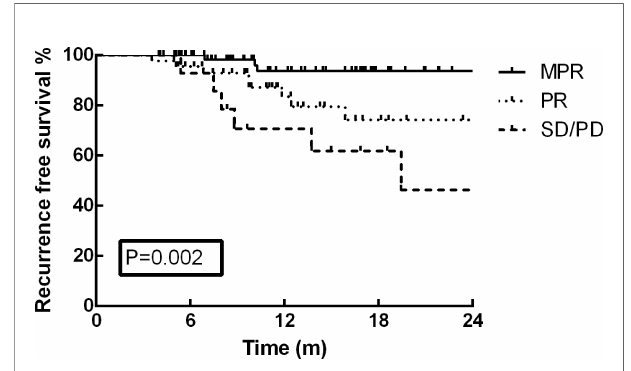
FIGURE 2 | The RFS rate of patients in MPR group was much better than that of PR and SD/PD groups in the present